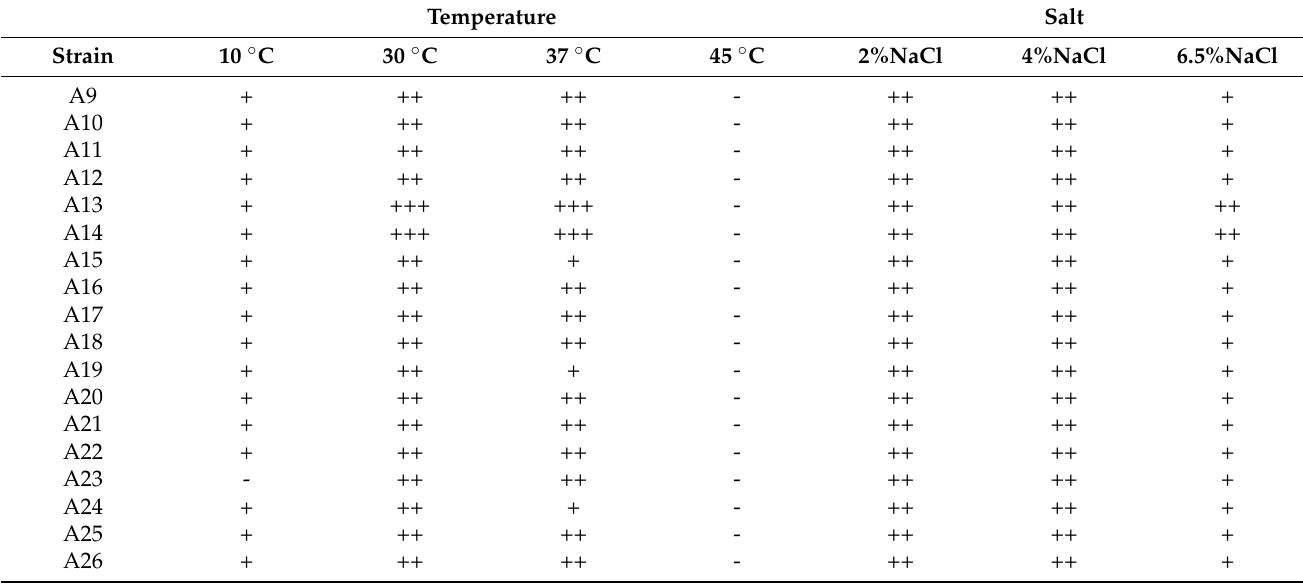
Figure 2. Maximum likelihood tree based on 16S rRNA sequences showing the phylogenetic analy- sis of the studied L. lactis isolates (bolded). Bootstrap values >50% are indicated. The scale bar dis- plays the number of nucleotide substitutions per site. The sequence of Bacillus subtilis was used as an outgroup. 3.3. Metabolism of Carbon Sources All the L. lactic isolates were tested for their ability to assimilate 49 carbohydrates and their derivatives using the API 50CH test (Table 2). After incubation, only 20 chemical compounds were used as media by the selected strains. All isolates of the bacteria were able to ferment glucose, lactose, ribose, fructose, mannose, galactose, N-acetyl-glucosa- mine, amygdalin, arbutin, esculin, salicin, cellobiose, maltose, turanose, and potassium gluconate. Some differences were found, i.e., the strains from group I were the only bac- teria that additionally assimilated glycogen, xylitol and gentiobiose, strains from group I and II additionally assimilated starch, and bacteria from group I and III utilized D-melibi- ose. No isolates were able to ferment glycerol, erythritol, D- and L-arabinose, D- and L- xylose, adonitol, methyl-ß-D-xylopiranoside, sorbose, rhamnose, inositol, dulcitol,